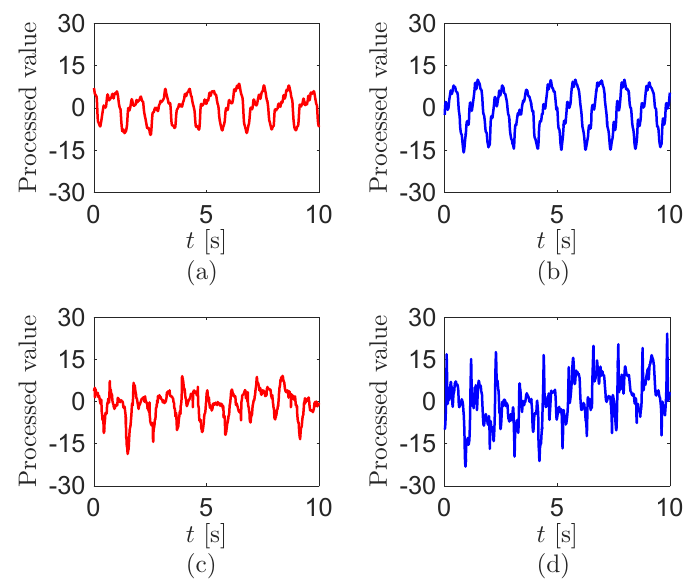
Figure 3. Signal processed values from the sensor outputs during walking at the ( a ) left hip; ( b ) right hip; ( c ) left knee; and ( d ) right knee. The test walking velocity is 4km/h.